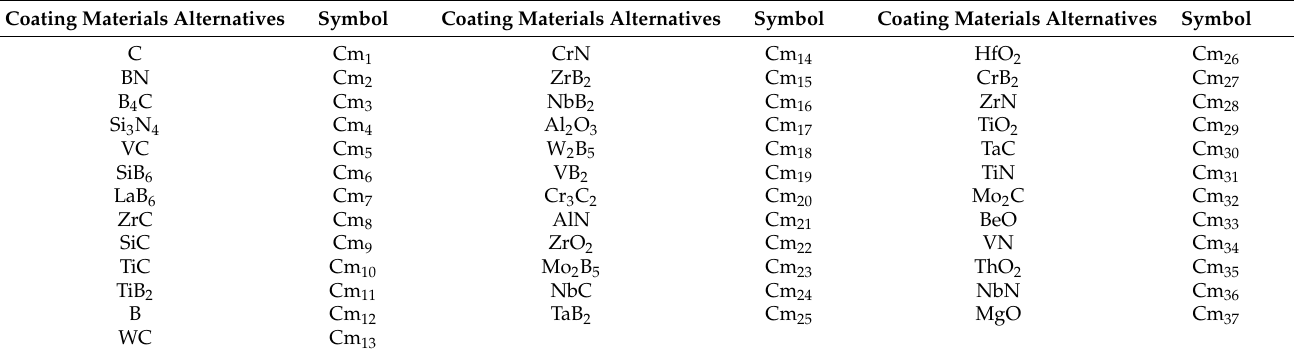
Table 9. Hard coating materials alternative.